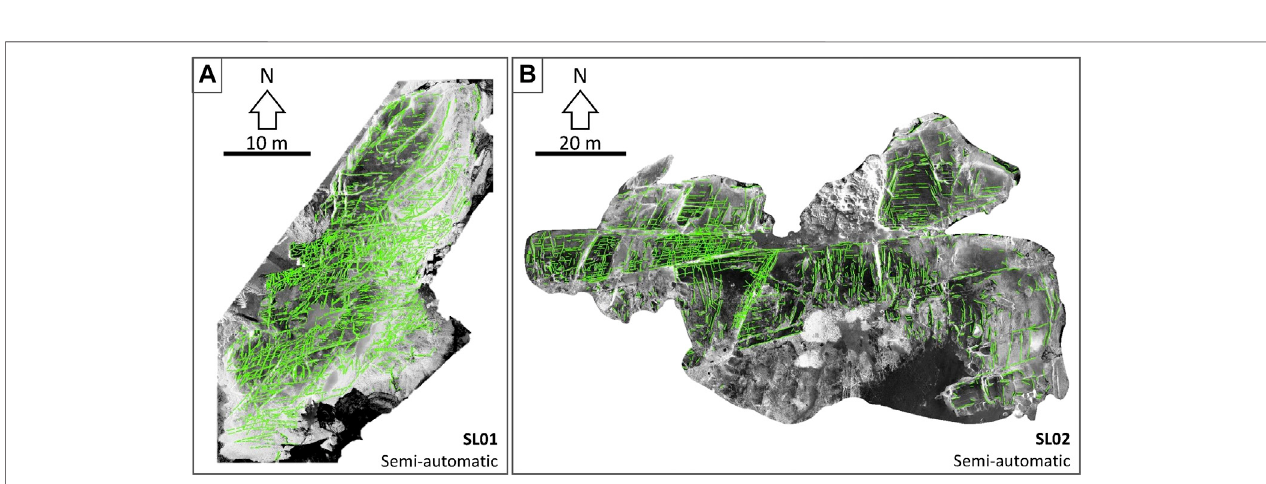
FIGURE 5 | Results of RGB-processed lineaments from the texture ofDSMs as fracture lineaments from the semiautomatic process in the outcrops SL01 (A) and SL02 (B) .